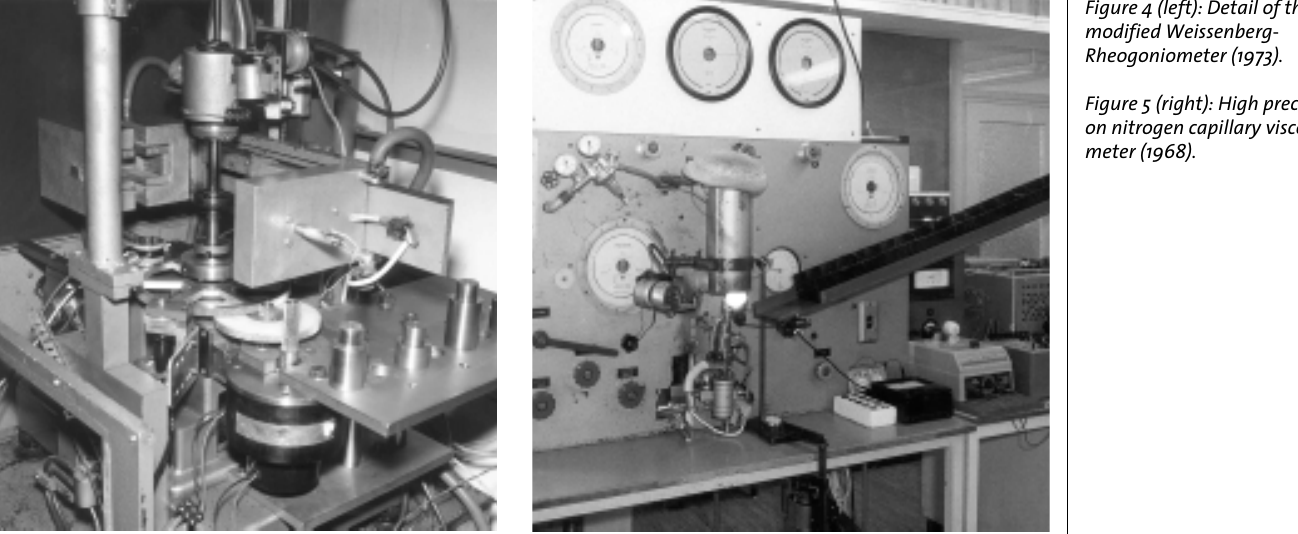
Figure 4 (left): Detail of the modified Weissenberg- Rheogoniometer (1973). Figure 5 (right): High precisi- on nitrogen capillary visco- meter (1968).